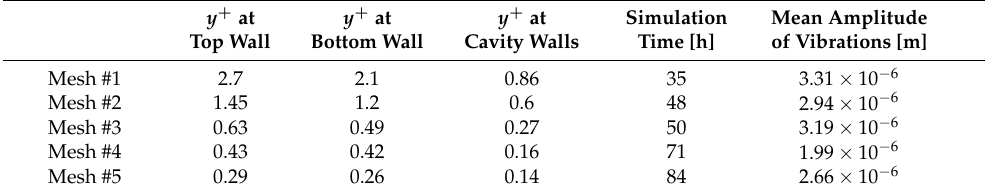
Table 6. Parameter y + , time of simulation, and amplitude of vibrations at point S3 for differ- ent meshes. y + at y + Top Wall